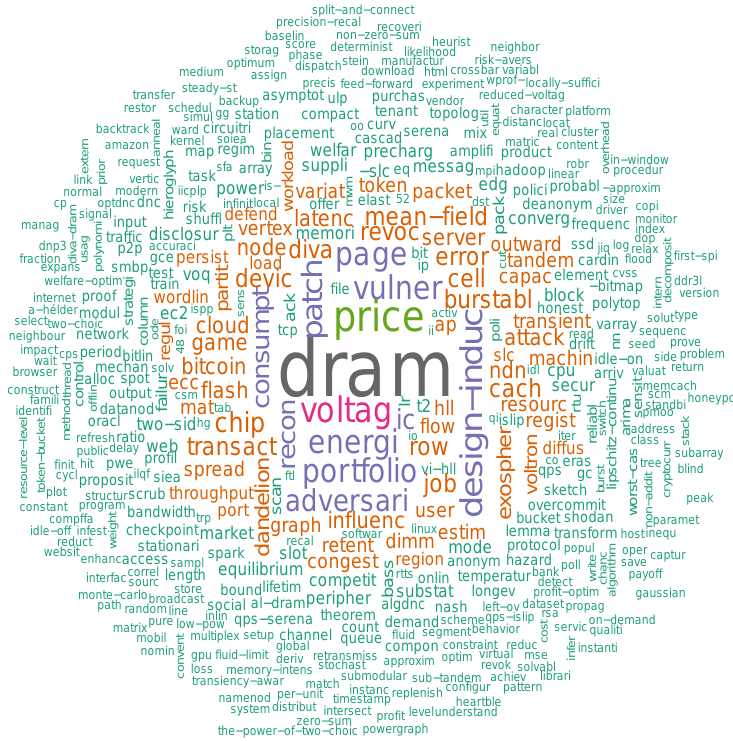
Figure 8. Word cloud of top terms by TF-IDF, weighted by log(citations +